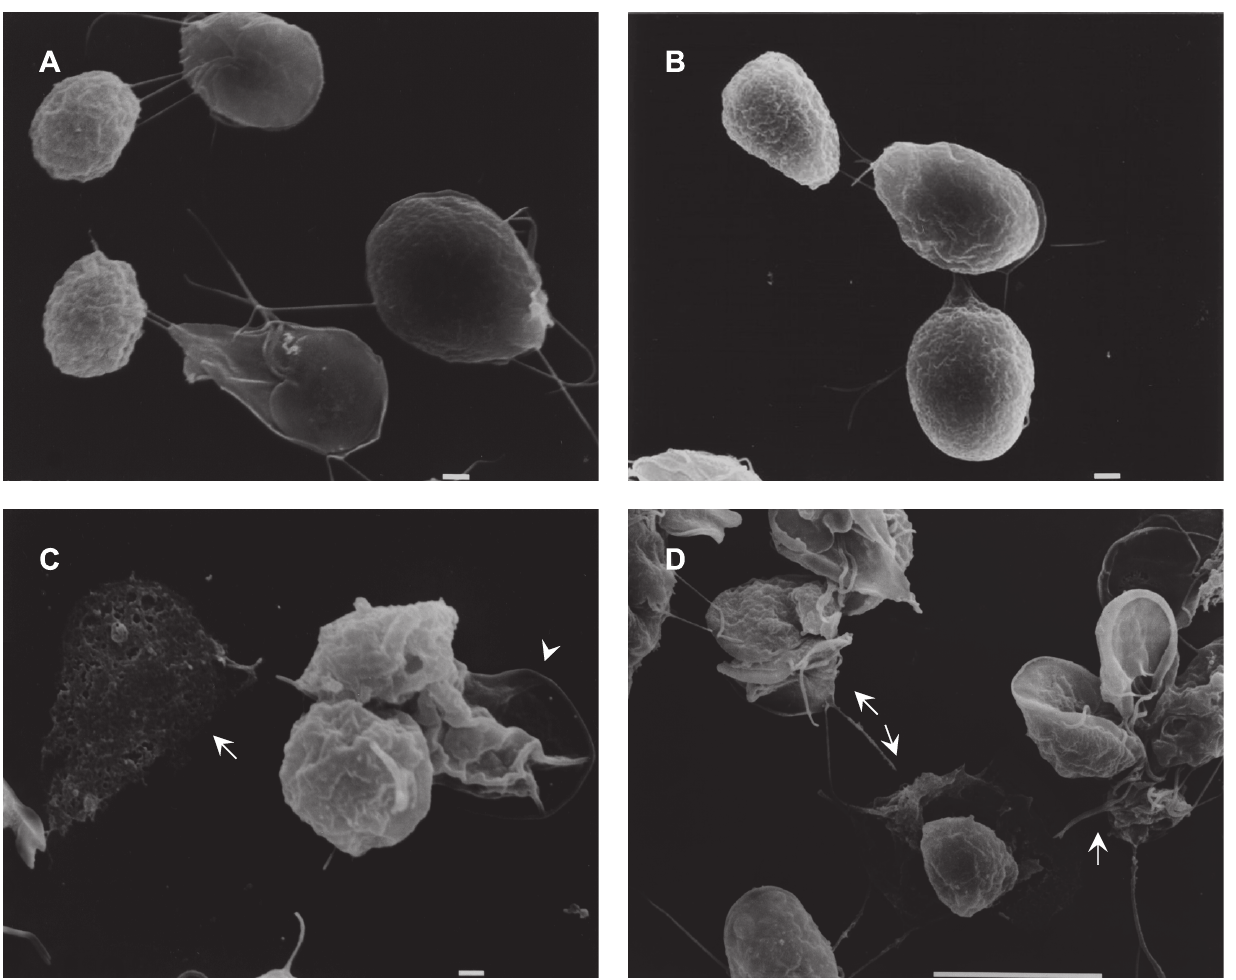
Figure 8. SEM micrographs of parasites treated with LA. Samples of cells induced to undergo encystation in the presence of 1 m M LA for 24 h were processed for SEM as described in the Methods section. ( C and D ) 1 m M LA. ( A and B ) 0.1% DMSO, control samples. Bars indicate 1 and 10 m m. Arrows indicate damaged cells, arrowhead indicates cysts with extracellular peritrophic space altered.